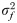
Stochastic noise in CCG-2 as a function varies systematically with hypothesized ratios of RNA/DNA and protein/DNA ratios within a single cell.The total stochastic noise σf2 averaged over frequencies (f) in CCG-2 expression is computed from bootstrapping the 1024 Gillespie trajectories. The red dot denotes the experimentally determined ratios (see Table 1) and corresponds to a RNA/DNA and protein/DNA ratio of 128.7 and 412, respectively. The model ensemble used is described in Table 2; the model selected was one with minimum chi-squared statistic based on the Likelihood in Eq (1) for 868 single cells.